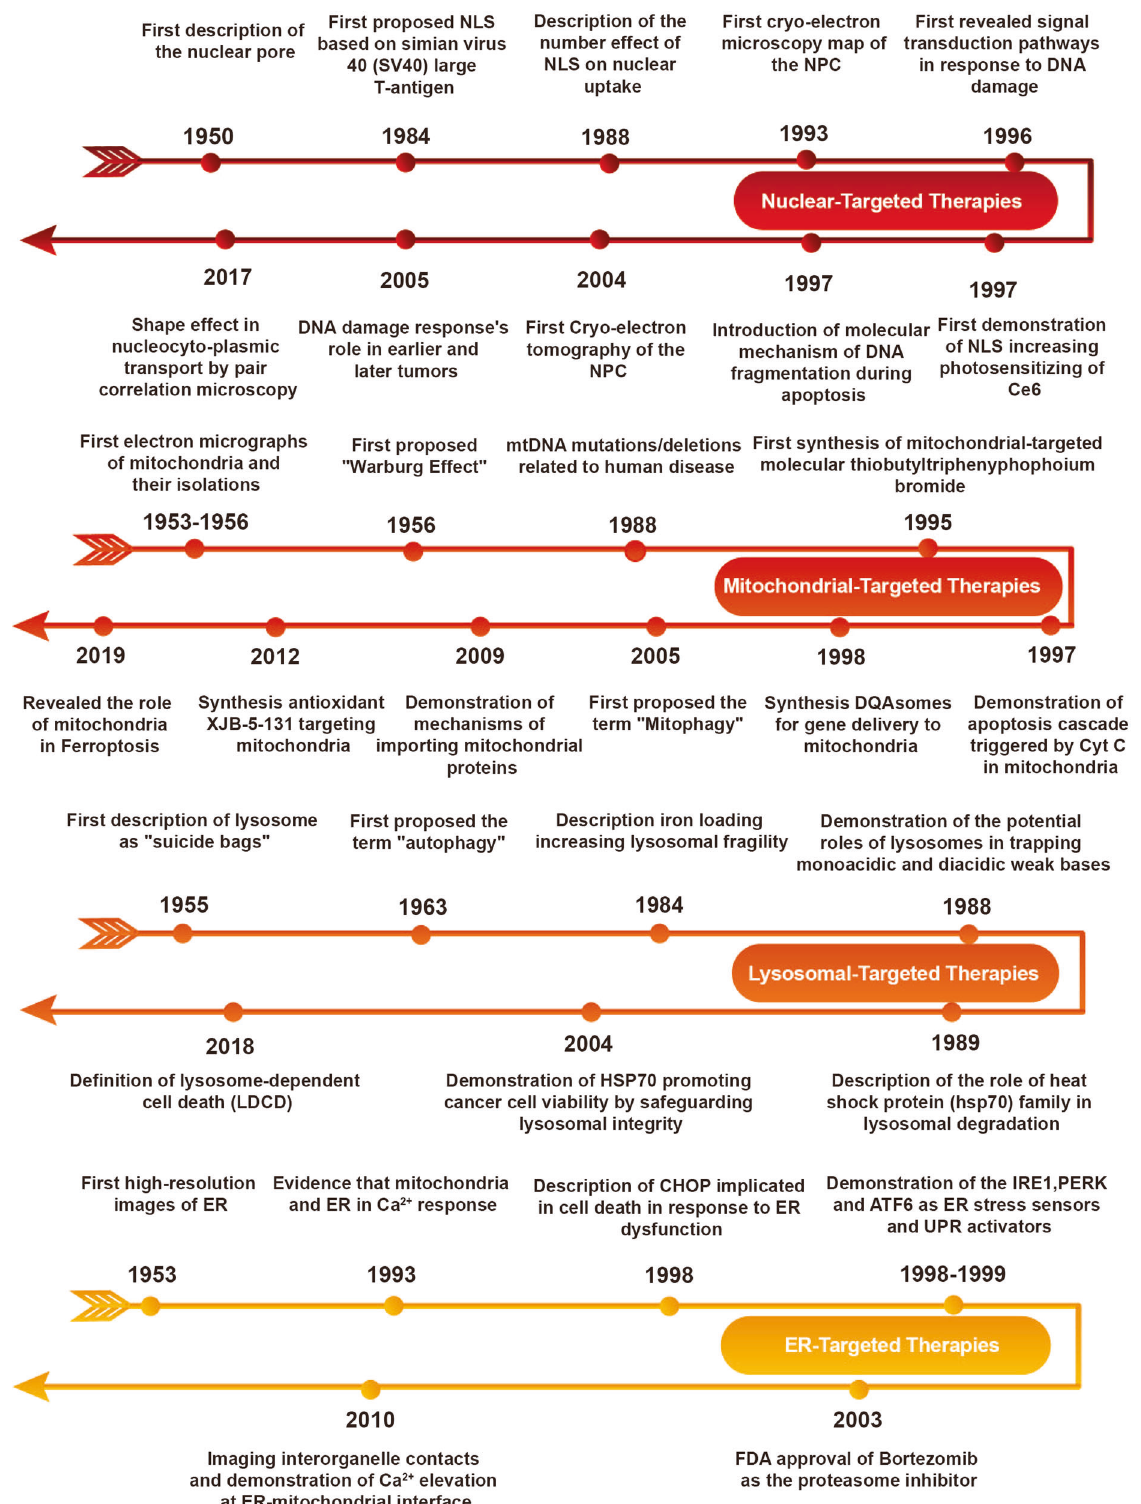
Fig. 2 Timeline of the key advances in developing organelle-targeted therapies